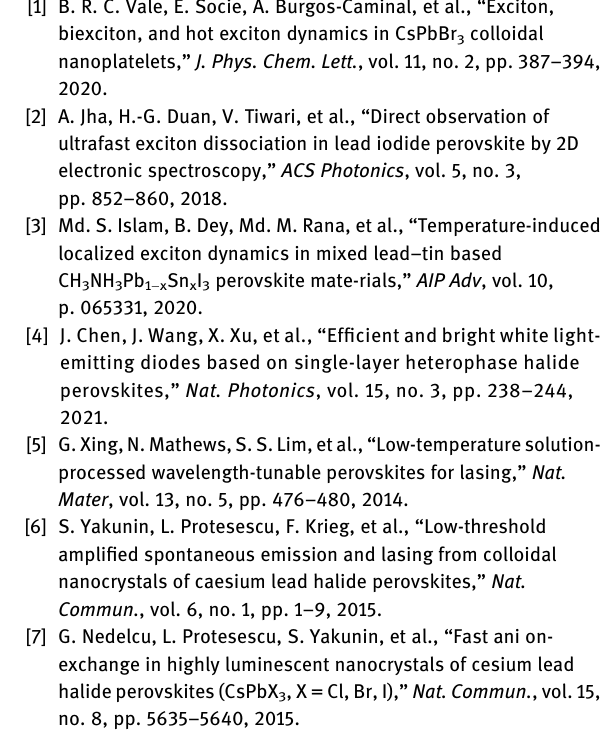
Figure 6: (a) Size dependence of biexciton binding energy of CsPbBr 3 and CsPbI 3 quantum dots [15]. (b) Estimated excess energy dependence of the biexciton binding energy (red dots)